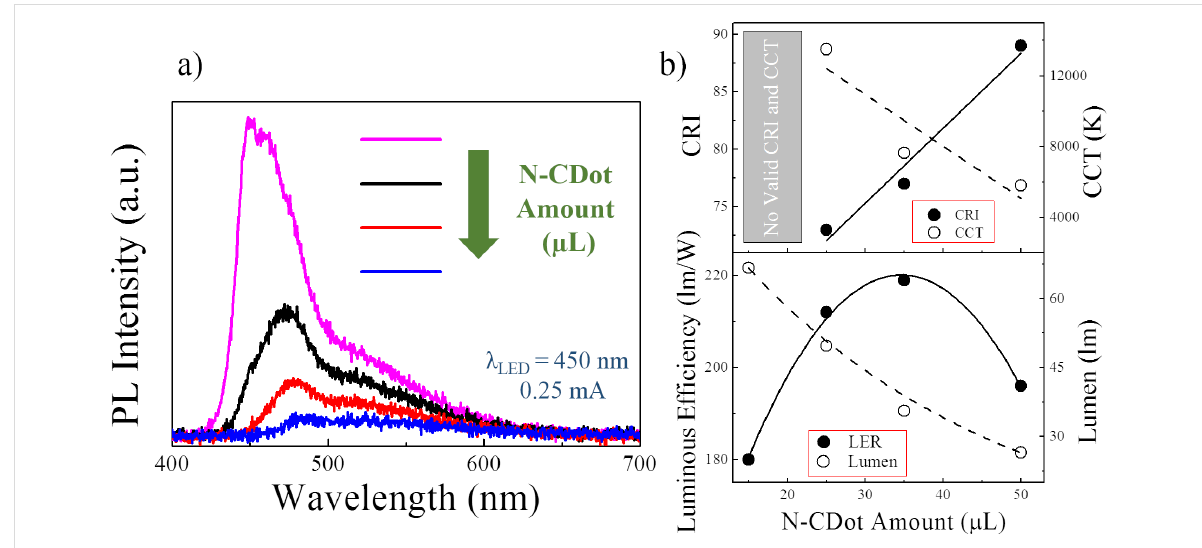
Figure 3: (a) PL spectra of white light generated by employing the PVP/N-CDot drop-cast films layered over a 450 nm blue LED chip as a function of the N-CDot amount (µL) (pink line: 15 µL, black line: 25 µL, red line: 35 µL and blue line: 50 µL). (b) Calculated CRI, CCT, LER and luminous flux (lumen) values of the related drop-cast films with different amounts of N-CDots.